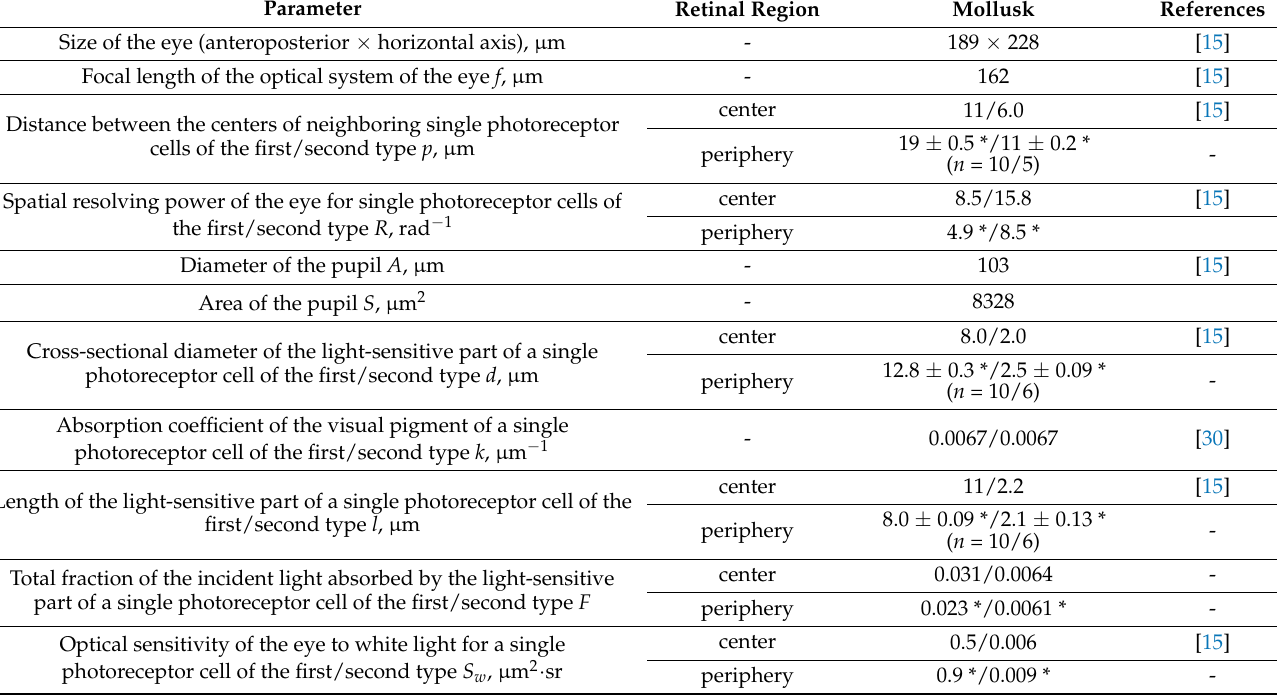
Table 1. Parameters of the mollusk eye.